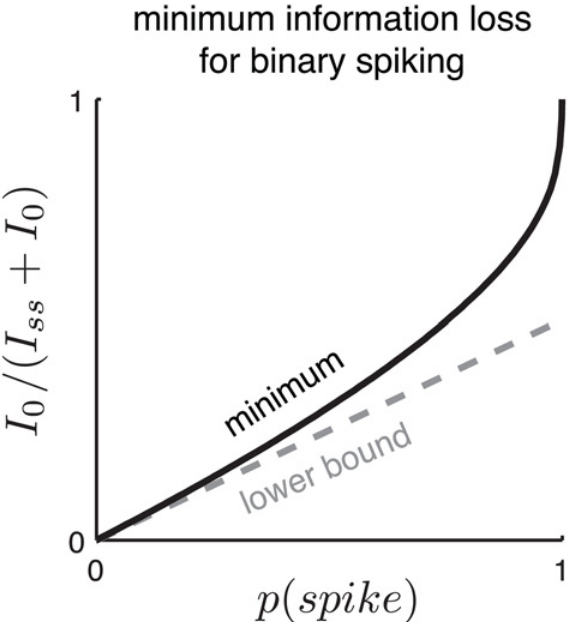
Fig 6. Lower bound on the fraction of total information neglected by MID for a Bernoulli neuron, as a function of the marginal spike probability p ( spike ) = p ( r = 1), for the special case of a binary stimulus. Information loss is quantified as the ratio I 0 /( I 0 + I ss ), the information due to no-spike events, I 0 , divided by the total information due to spikes and silences, I 0 + I ss . The dashed gray line shows the lower bound derived in the limit p ( spike ) ! 0. The solid black line shows the actual minimum achieved for binary stimuli s 2 {0,1} with p ( s = 1) = q , computed via a numerical search over the parameter q 2 [0, 1] for each value of p ( spike ). The lower bound is substantially loose for p ( spike ) > 0, since as p ( spike ) ! 1, the fraction of information due to silences goes to 1.